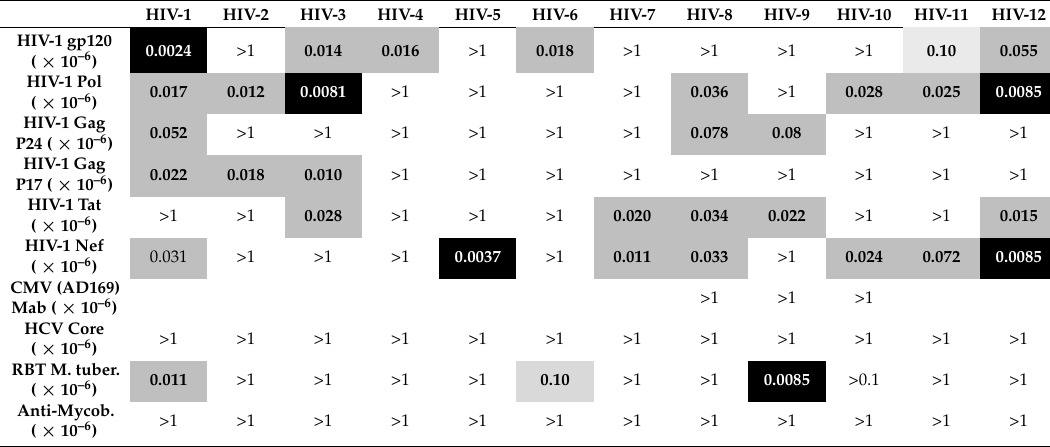
Binding constants highlighted in black are in the range of 10 − 9 M; highlighted in medium grey are in the range of 10 − 8 M; highlighted in light grey are in the range of 10 − 7 ; and those with white backgrounds had